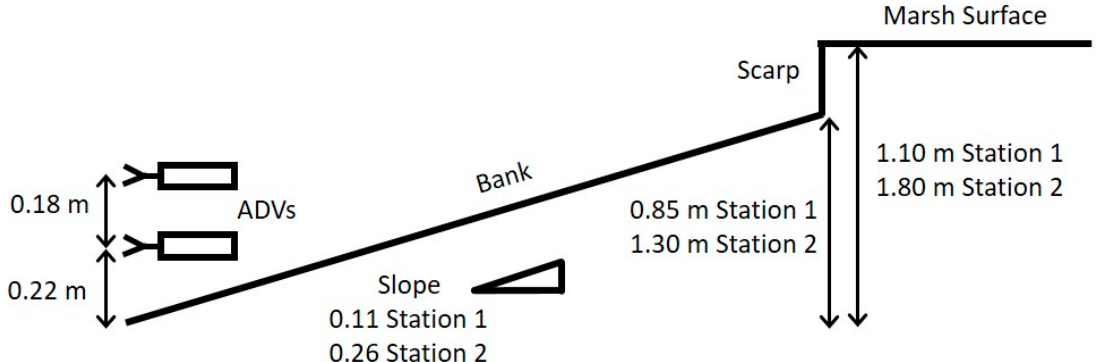
Figure 2. Definition sketch showing the location of the sensors relative to the bank and marsh platform. The height of the acoustic Doppler velocimeters (ADVs) above the bed is the same at both stations. The other measurements are labeled according to the shoreline characteristics at Station 1 or Station 2.